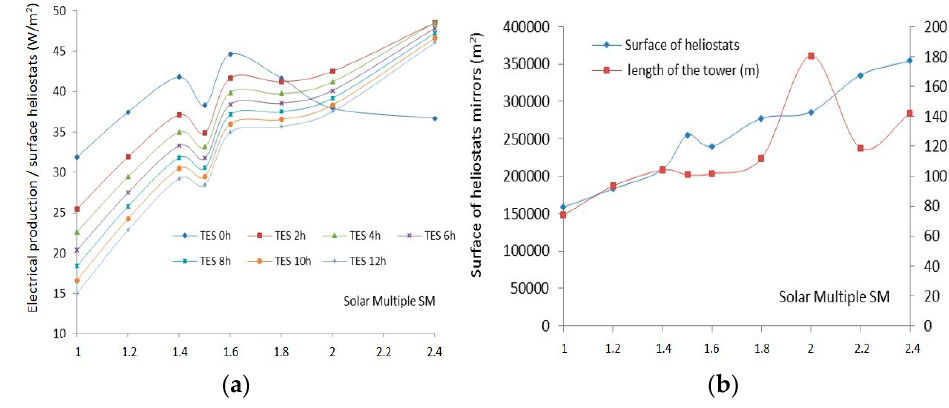
Figure 3. ( a ) Solar multiple effect ( SM ) on electrical production/surface heliostats under different values of TES (Béchar). ( b ) Solar multiple effect on the surface of the heliostats mirrors and length of the tower (Béchar).